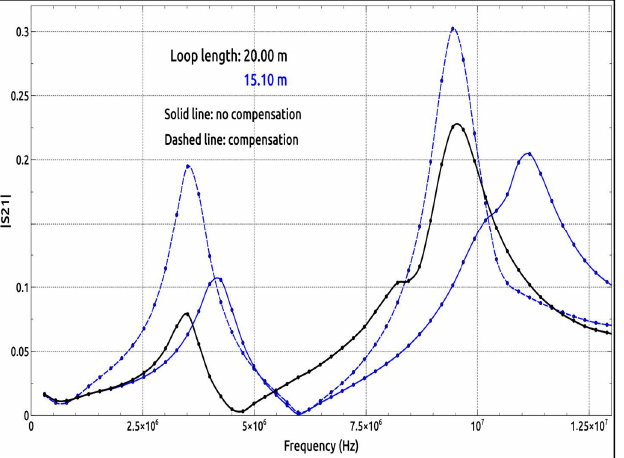
Figure 7. Effect of microcontroller action to retune the loop, in response to variations in cable dis- tance.